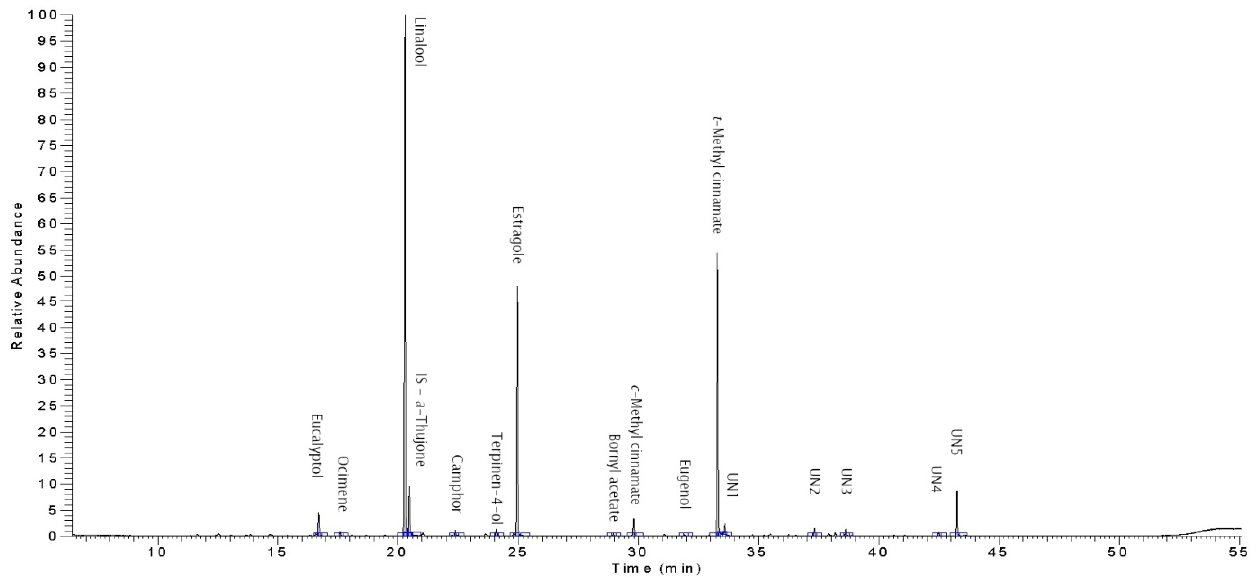
Figure 1. TIC chromatogram of the Ocimum sanctum essential oil.